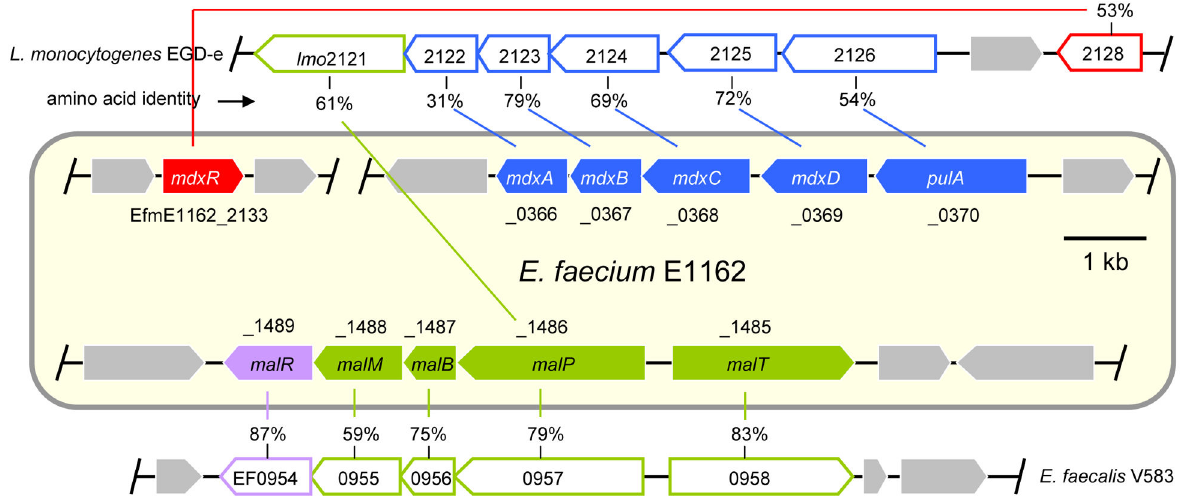
Figure 1. Schematic representation of the gene clusters involved in maltodextrin and maltose utilization of E. faecium E1162. Genes are represented by arrows (drawn to scale). Genes putatively encoding proteins involved in maltodextrin transport and/or metabolism are indicated in blue or in red. Genes predicted to be involved in the uptake and/or metabolism of maltose are indicated in green or in purple. The genes that encode putative transcriptional regulators are indicated in red or purple. The grey arrows represent the adjacent genes that are not predicted to be involved in maltodextrin or maltose utilization. Gene names, without the EfmE1162-prefix (omitted for reasons of space), are indicated in the arrows and the gene locus tags are indicated above or below the arrows. The homologs in L. monocytogenes EGD-e or in E. faecalis V583 are shown with corresponding colors above or below the gene clusters of E. faecium . The gene locus tags of the homologs are indicated in the arrows. Lines link the homologous genes with corresponding genes in E. faecium and amino acid identities are